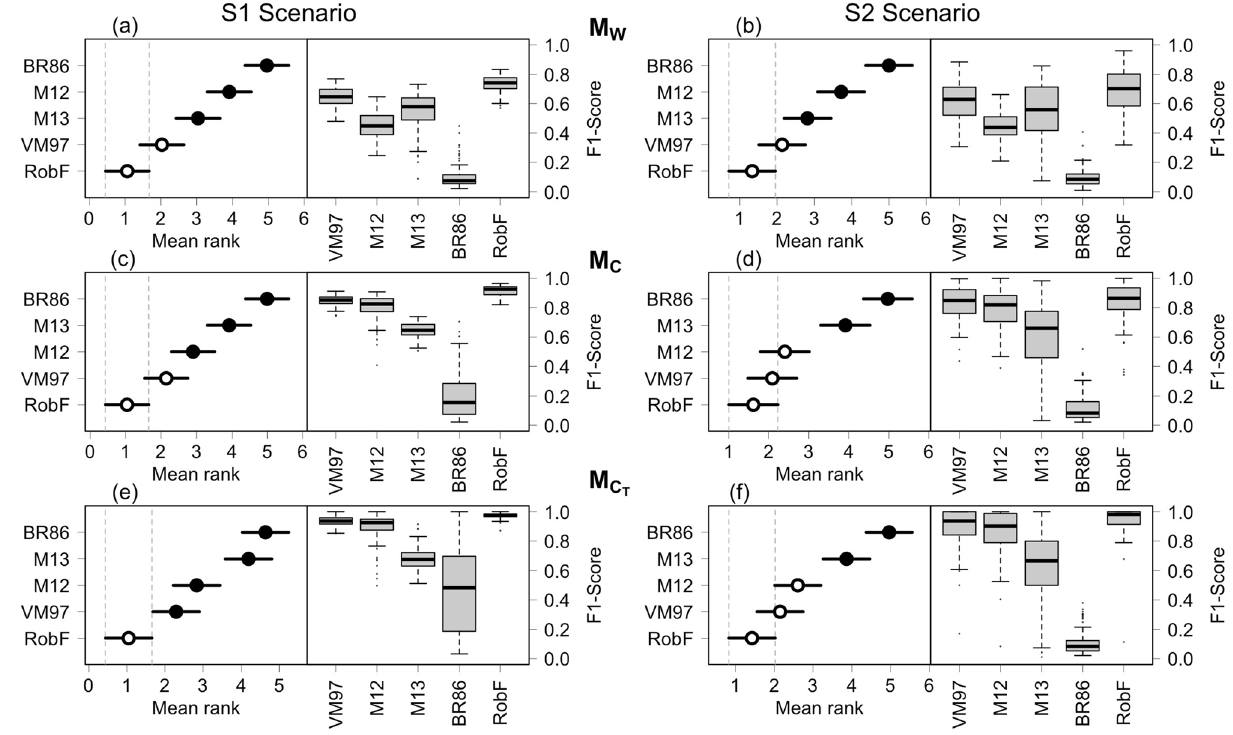
Figure 6. Graphical visualization of the Nemenyi test for the evaluation of the F1-Score performance metric. The algorithm with the lowest rank is the best performing. Panels a and b show the results obtained in S1 and S2 scenarios, respectively, using data simulated from the M W model. Panels c and d r show the results obtained in S1 and S2 scenarios, respectively, using data simulated from the M C model. Panels e and f show the results obtained in S1 and S2 scenarios, respectively, using data simulated from the M C T model. White dots indicate there is not statistically significant difference between the performances of the algorithms. In all scenarios, the null hypothesis of the Friedman test that there are no significant differences between performances of all the considered algorithms is rejected at 0.05% significance